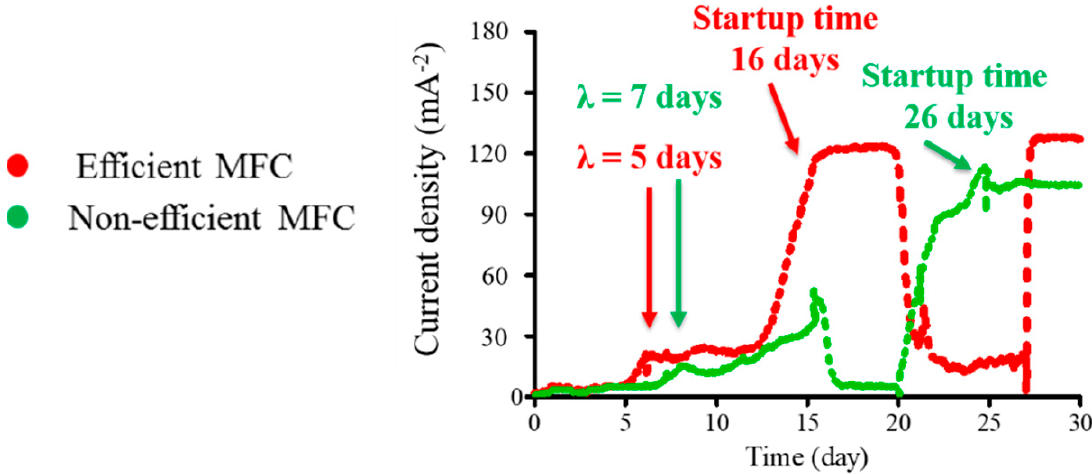
Figure 1. Current density production growth curve of two representative microbial fuel cells (MFCs), efficient and non ‐ efficient. λ is lag phase length, the time it took to reach 30 mV.